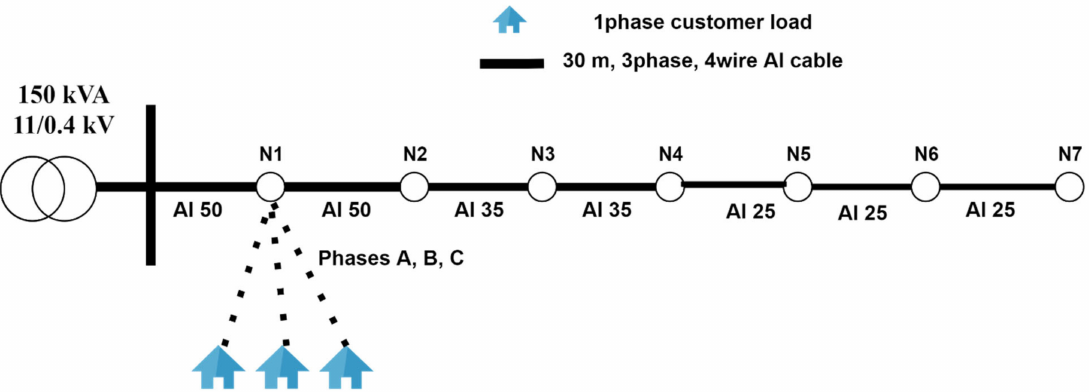
Figure 4. Configuration of the designed